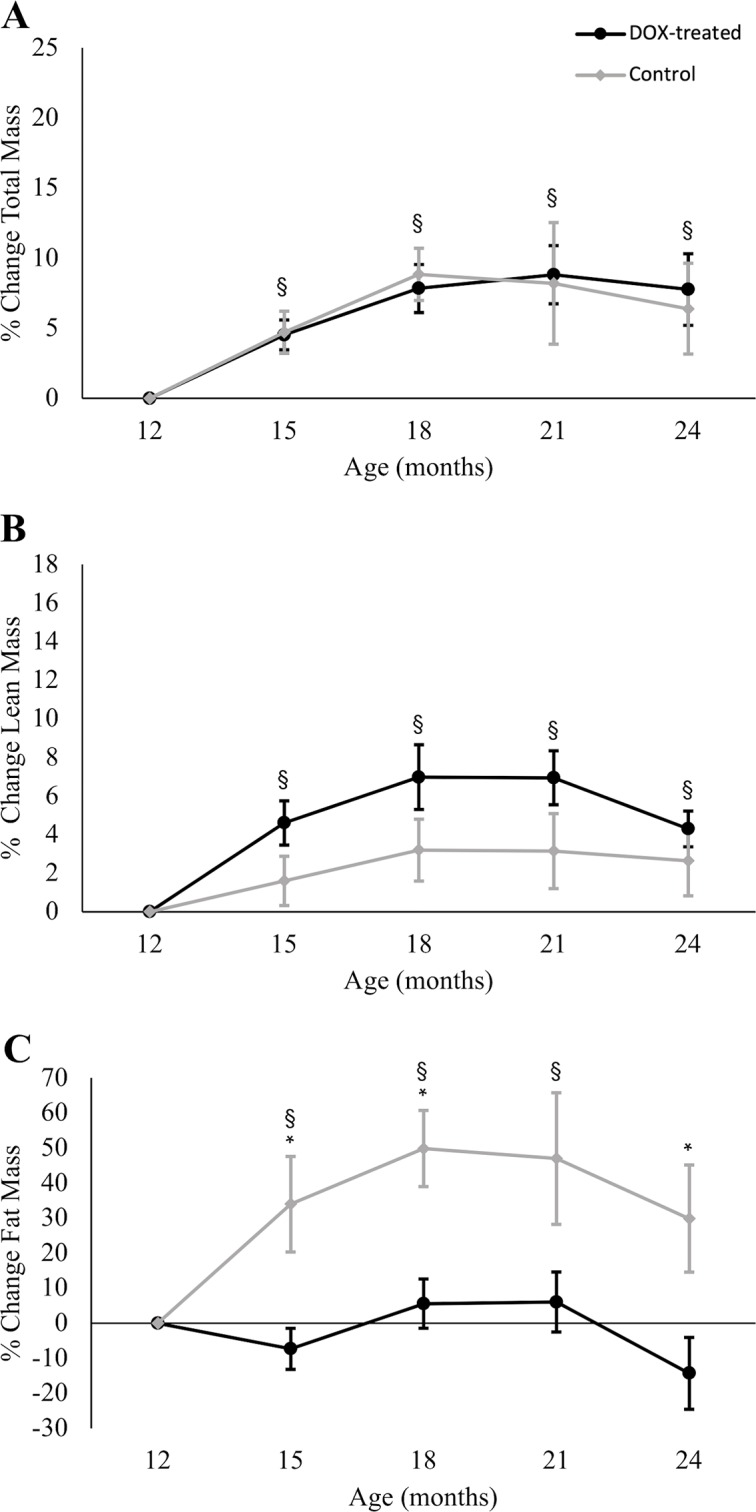
Changes in total, lean, and fat mass in treated and control male mice.(A) Compared to the 12-month baseline, total body mass in males was significantly higher at all time points, but there was no effect of DOX treatment. (B) Lean mass in males was also significantly higher at all time points, compared to 12-month baseline, with no effect due to DOX treatment. (C) The change in fat mass, however, was significantly higher than 12-month baseline at 15, 18 and 21 months of age. In addition, there was a treatment effect, and DOX-treated males had significantly less fat accumulation than male controls at 15, 18 and 24 months of age. To show the main effect of time, DOX-treated and control values were pooled and the comparison to baseline indicated with § (p<0.05); the asterisk (*) indicates significant difference between DOX-treated and control mice at specified time points (p< 0.05). Values are mean ± SEM.